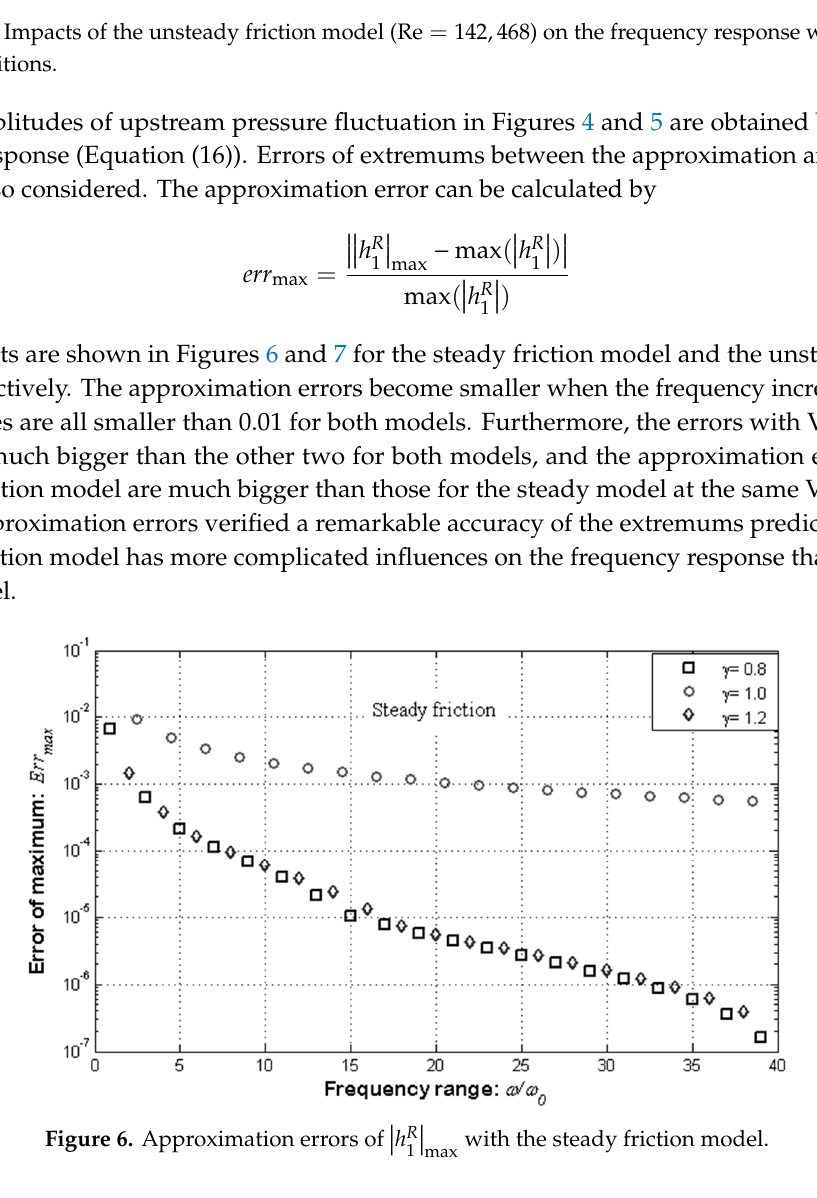
Figure 6. Approximation errors of 1